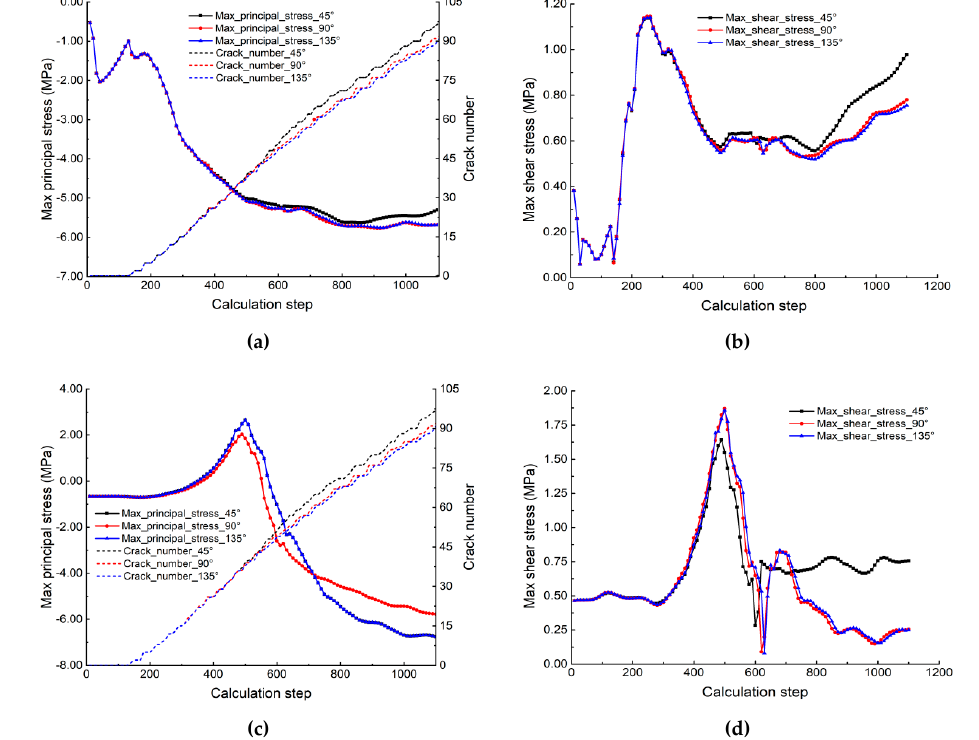
Figure 10. Principal stress curves of Group 2A under water pressure of 10.30 MPa: ( a ) max principal stress history curve of Mc1; ( b ) max shear stress history curve of Mc1; ( c ) max principal stress history curve of Mc2; and ( d ) max shear stress history curve of Mc2.